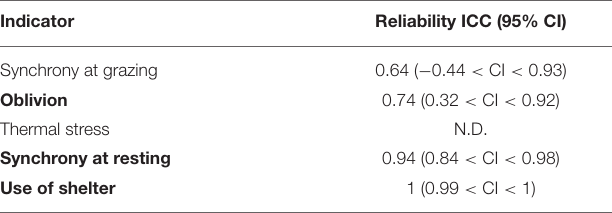
TABLE 4 | Inter-observer reliability for group-level